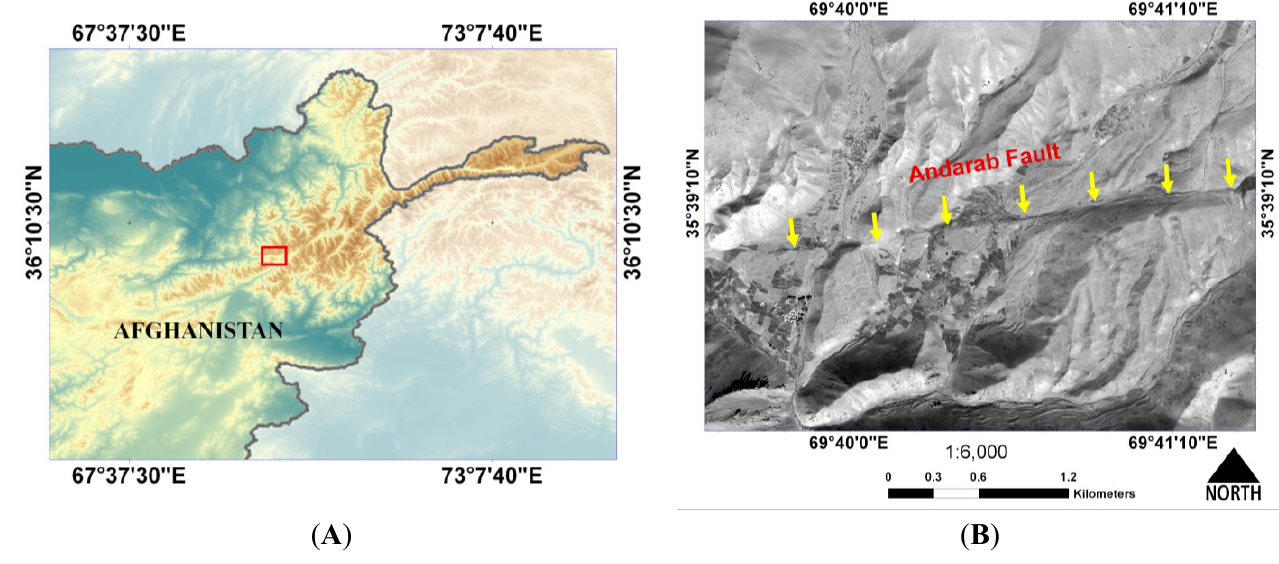
Figure 2. ( A ) location of the study area in northeast Afghanistan; ( B ) panchromatic band of the Quickbird-2 (1 m spatial resolution) for 2 March 2006 of the study